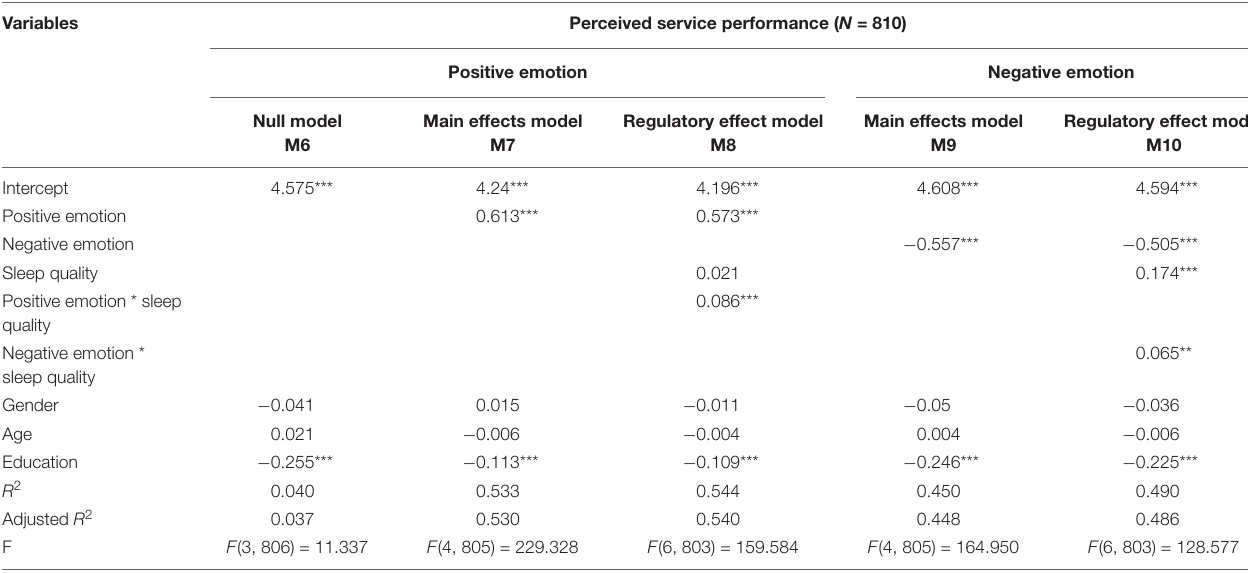
TABLE 4 | Multilevel analyses: Perceived service performance by daily emotion fluctuations and sleep quality.